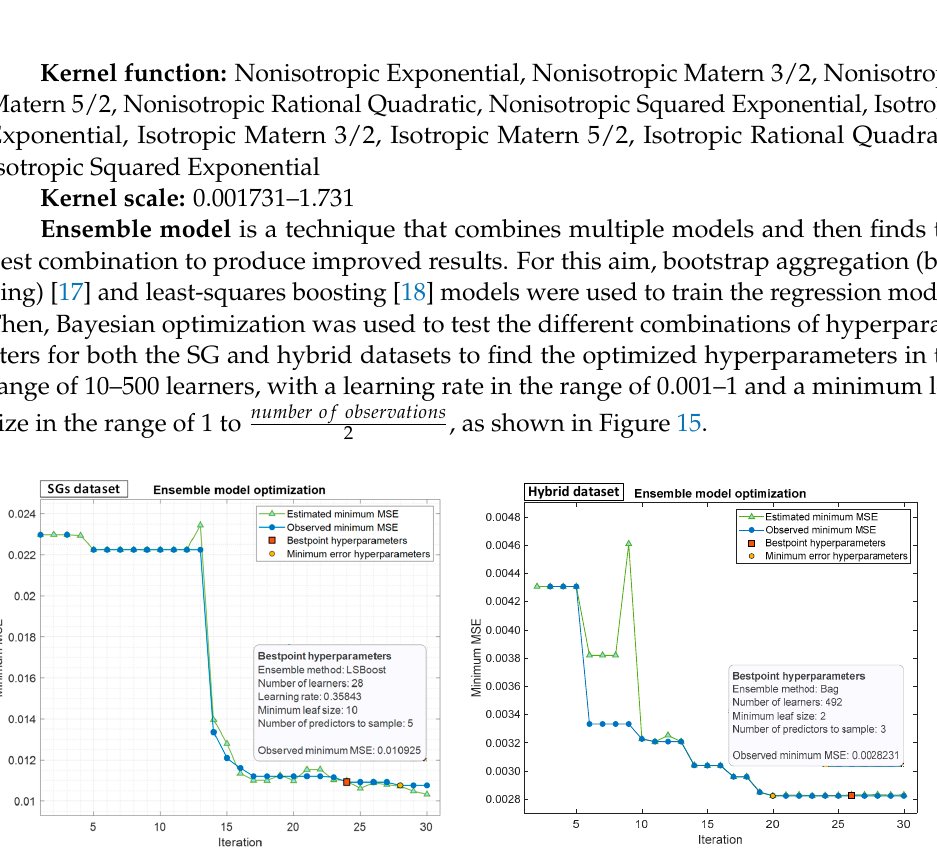
Figure 14. Minimum MSE plots for GPR method in both experimental and hybrid datasets, which were updated by Bayesian optimization runs.